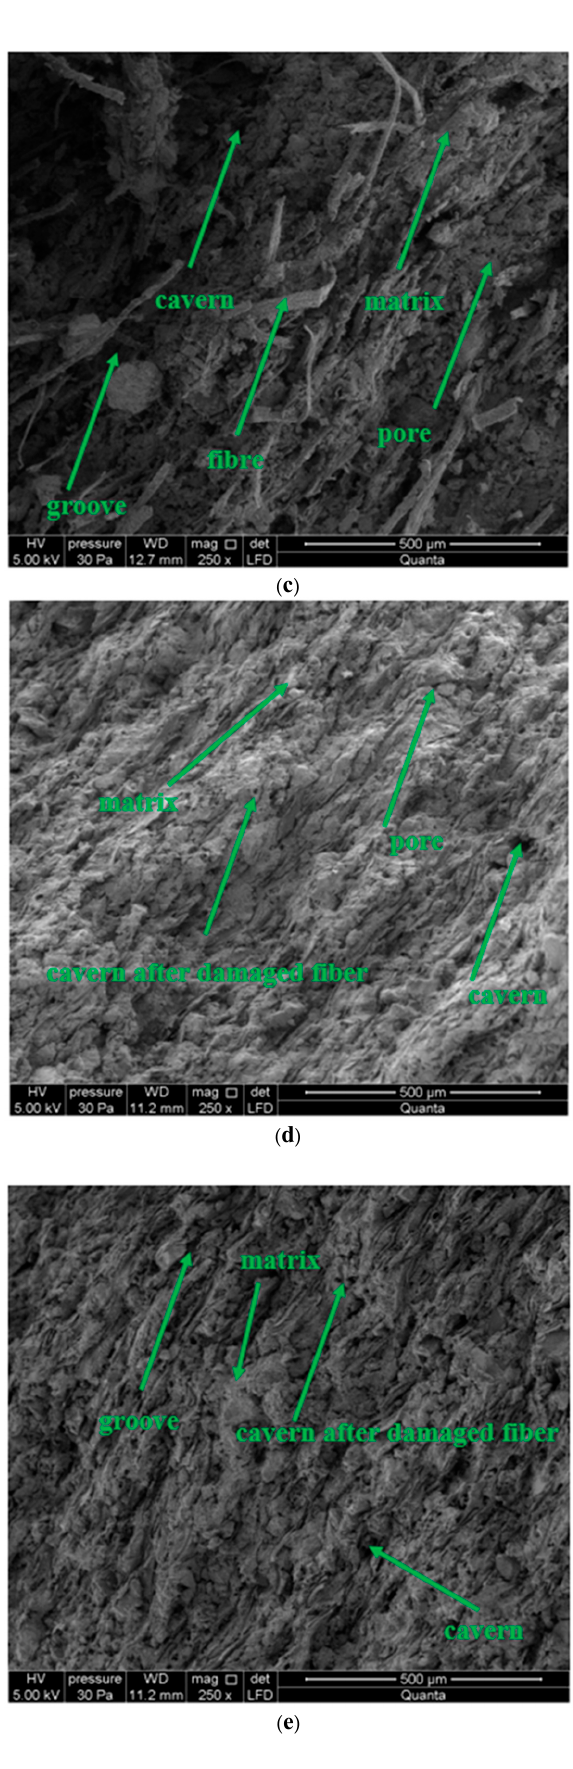
Figure 13. Image of the mock microstructure: ( a ) of BS sample, ( b ) of BW sample, ( c ) of BM sample, ( d ) of BP sample, and ( e ) of BC sample.